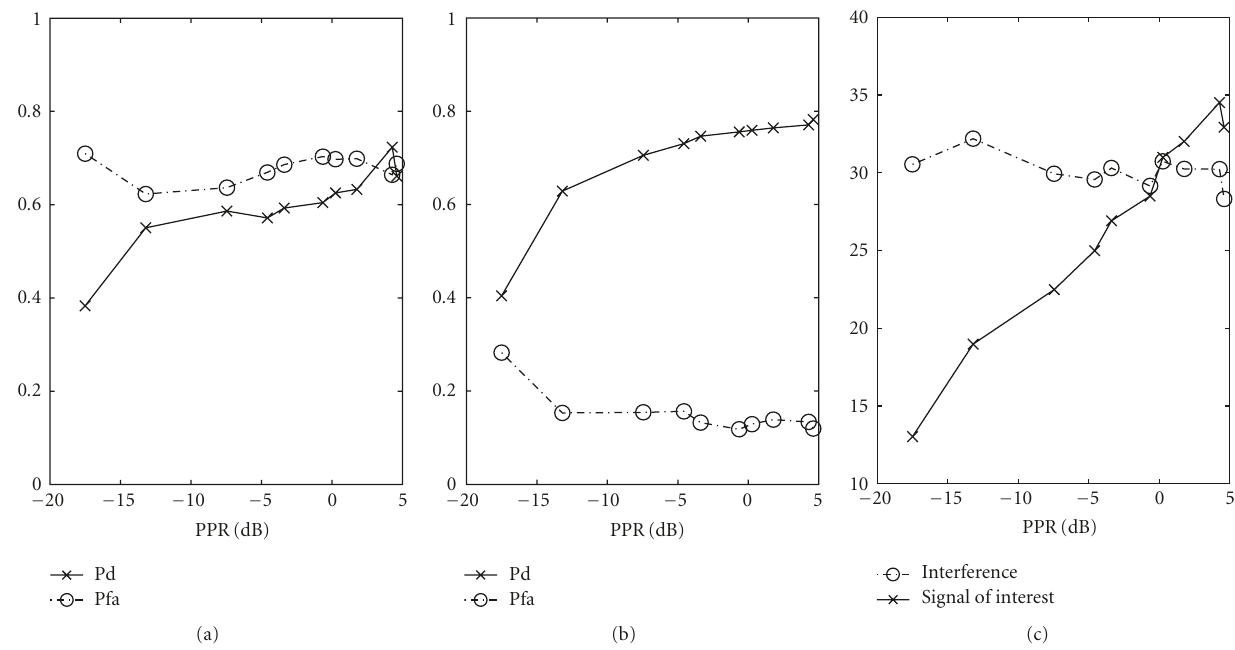
Figure 7: (a) results of interactive masking. Shown are the detection (Pd) and false alarm (Pfa) probabilities as a function of peak-to-peak ratio (PPR) of SI and IS; (b) the same as in A but for automated masking; (c) SNR of signal of interest and interfering signal; All results are based on 500 runs, 50 runs per each value of